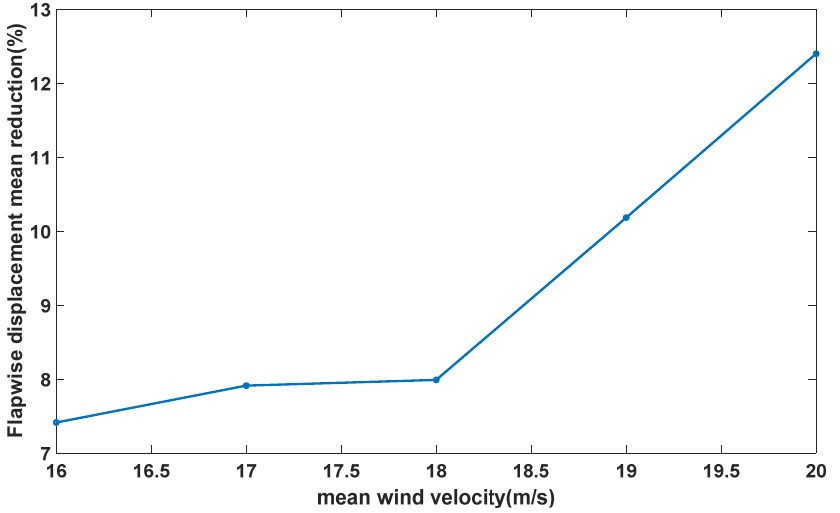
Figure 19. Flapwise displacement mean reduction in different mean wind velocities. The super twisting sliding mode can reduce the mean value of vibration signal by 7% to 12% in different mean wind velocities and turbulence intensity 10%.